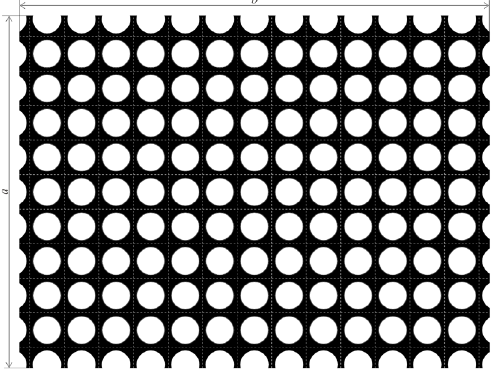
Fig. 8. A matrix of round marks in the field of view of the recording